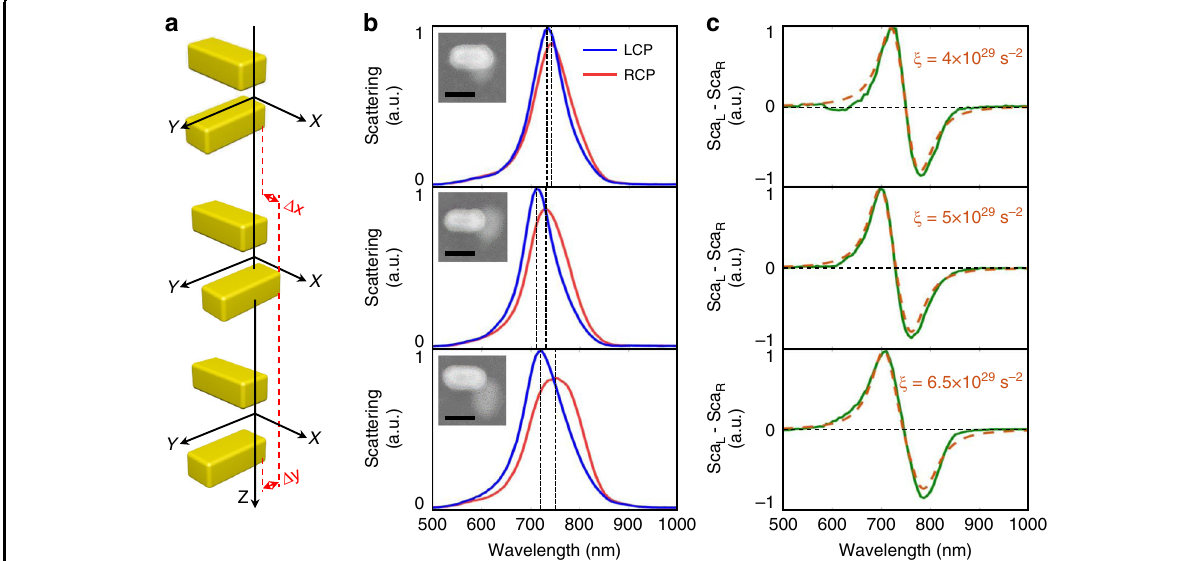
Fig. 3 Geometry-dependent SCD spectra. a Structure illustration of the vertically coupled nanorod pairs with different displacements. b The left- hand and right-hand circularly polarized components of the scattered spectra of the nanorod pairs. The insets are the correlated SEM images. Scale bar: 100 nm. c The SCD spectra of the samples. The dashed lines are the fi tting results based on the Born – Kuhn